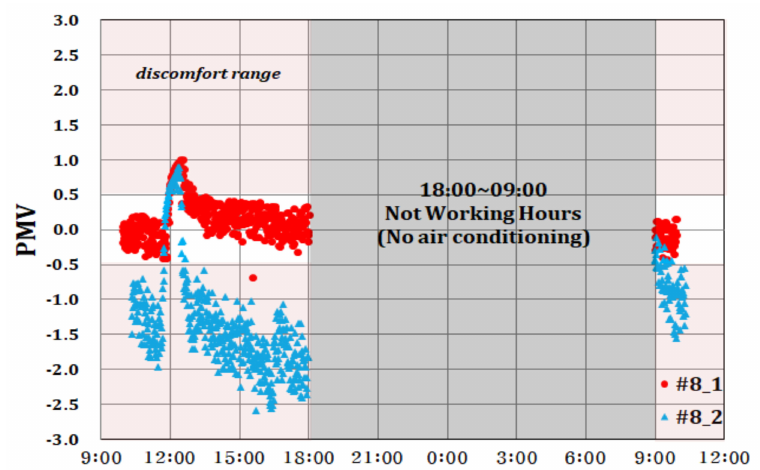
Figure 4. Example of PMV data for Building 7.